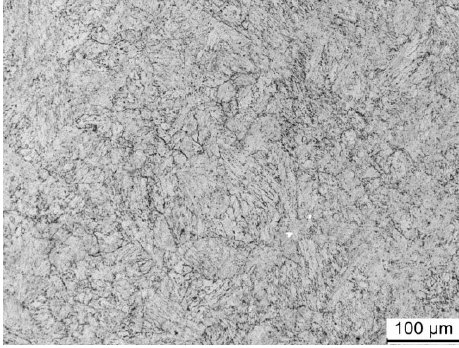
Figure 3. SEM image of 18Ni(300) maraging steel after heat treatment.